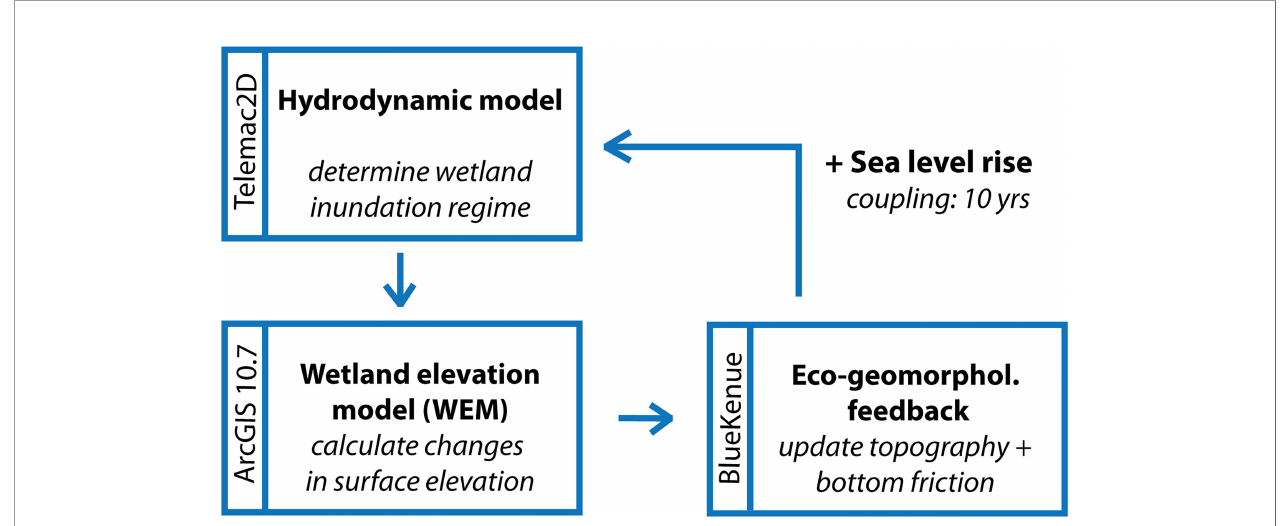
FIGURE 2 | Schematic illustration of the coupled hydrodynamic-wetland modelling